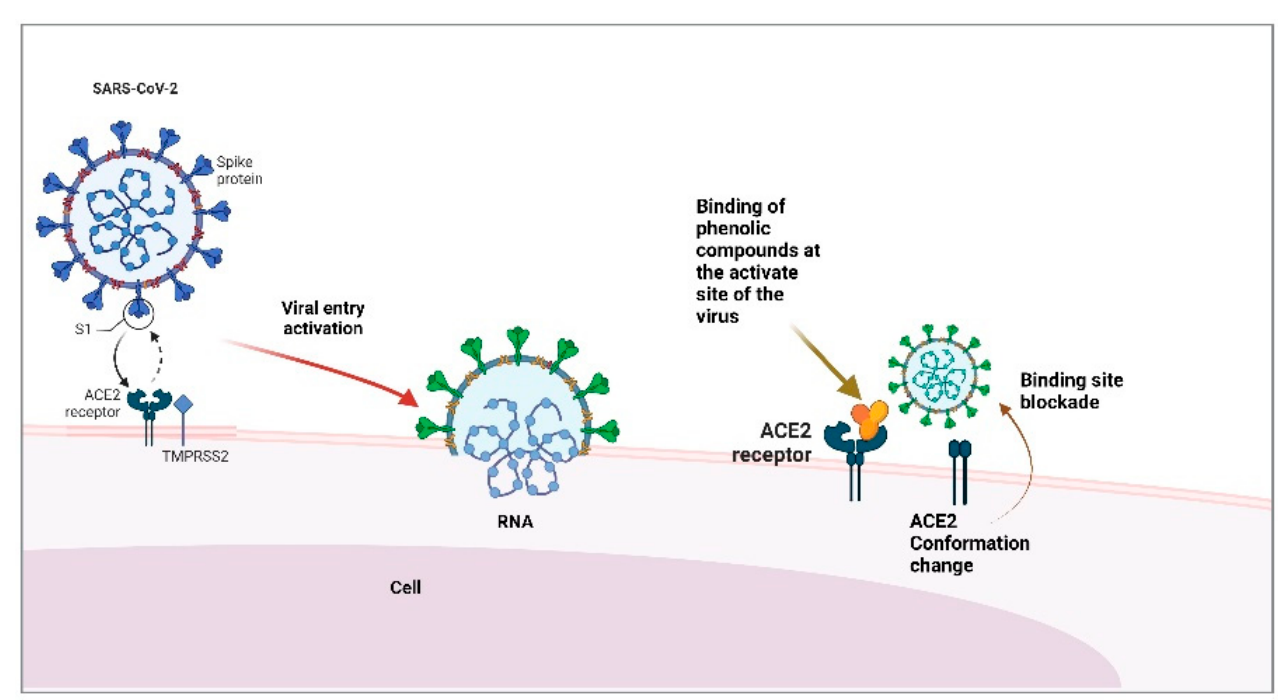
Figure 2. Phenol binding to the ACE2 receptor and protein S blockade of SARS-CoV-2. Created with BioRender.com (accessed on 28 August 2022).